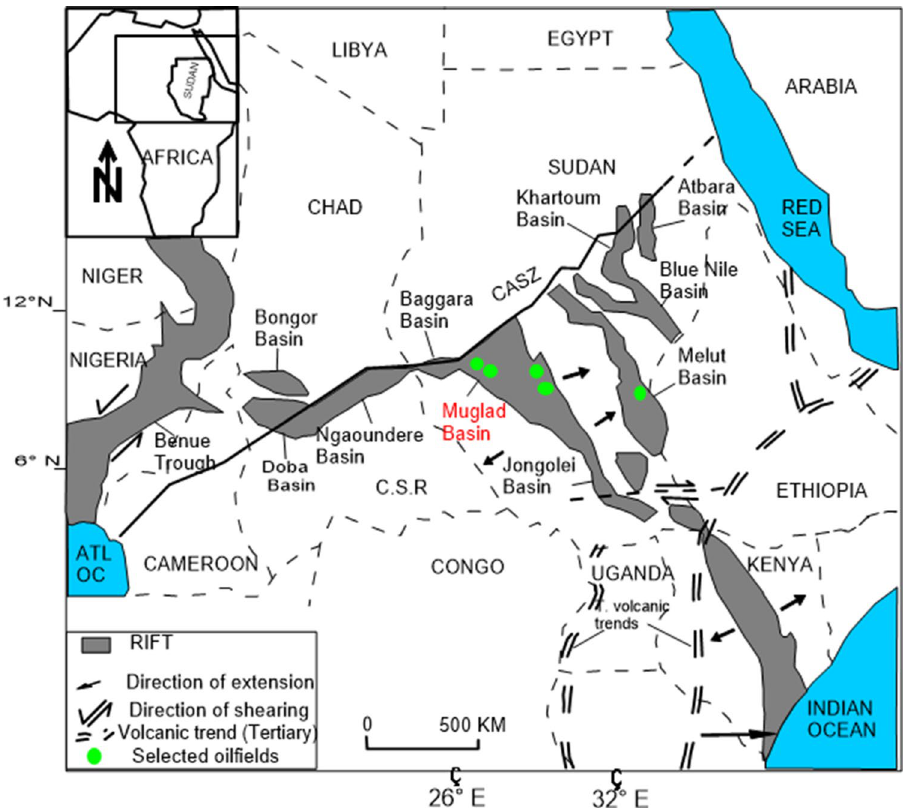
Figure 4. Location of the major basins across north north central Africa to the Benue Trough in Nigeria, through Chad and Sudan in relation to the Central African Shear Zone (created from information in reference 16 ).